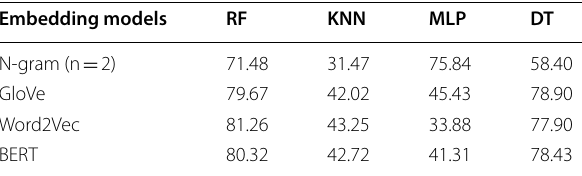
Table 12 Accuracy (%) of 16 combination of 4